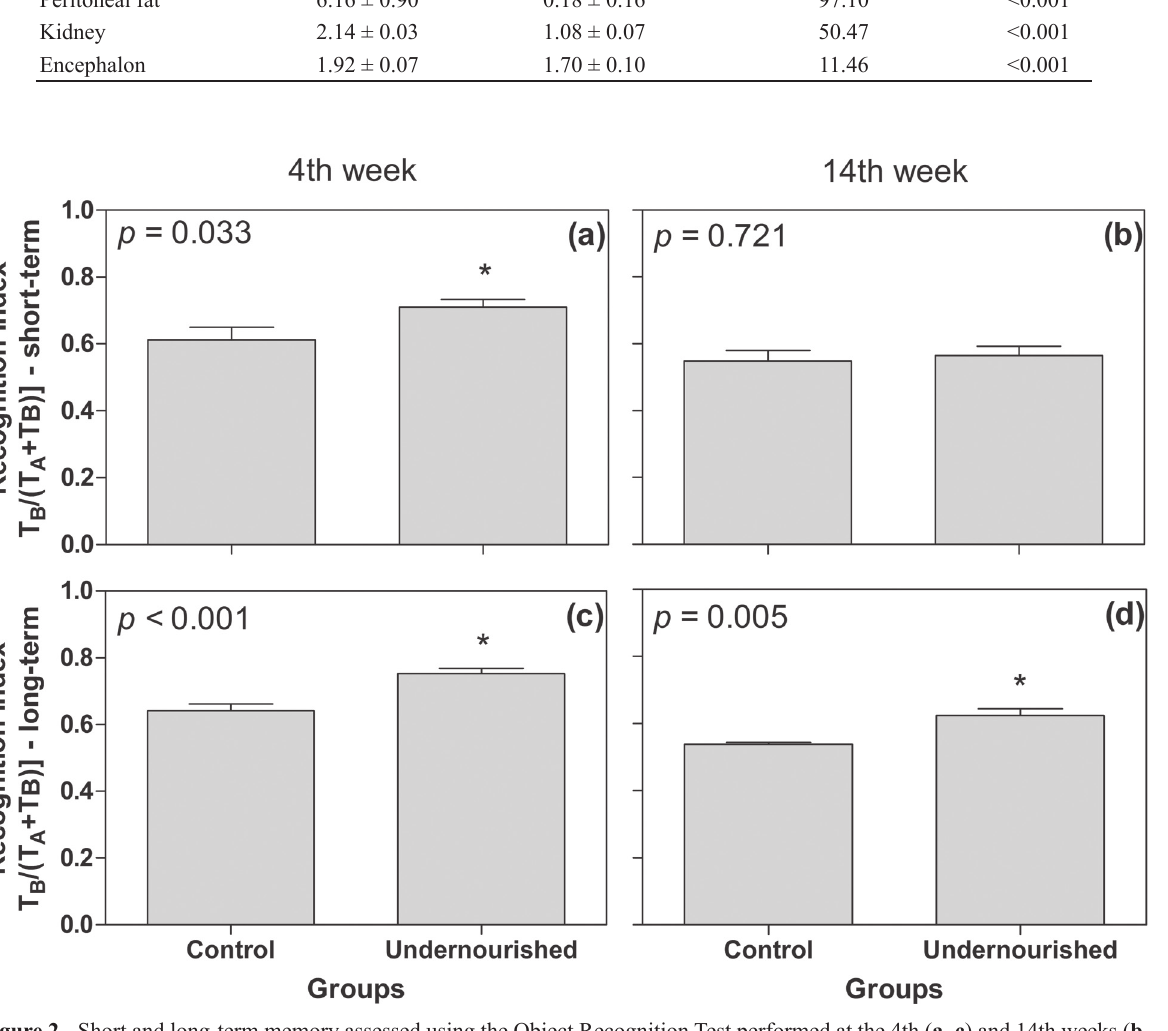
Figure 2 - Short and long-term memory assessed using the Object Recognition Test performed at the 4th ( a , c ) and 14th weeks ( b , d ) of caloric restriction. The data are expressed as mean and standard deviation. p : significance level according to the Student t test. In the bars, significative diference is highlighted by “*”.